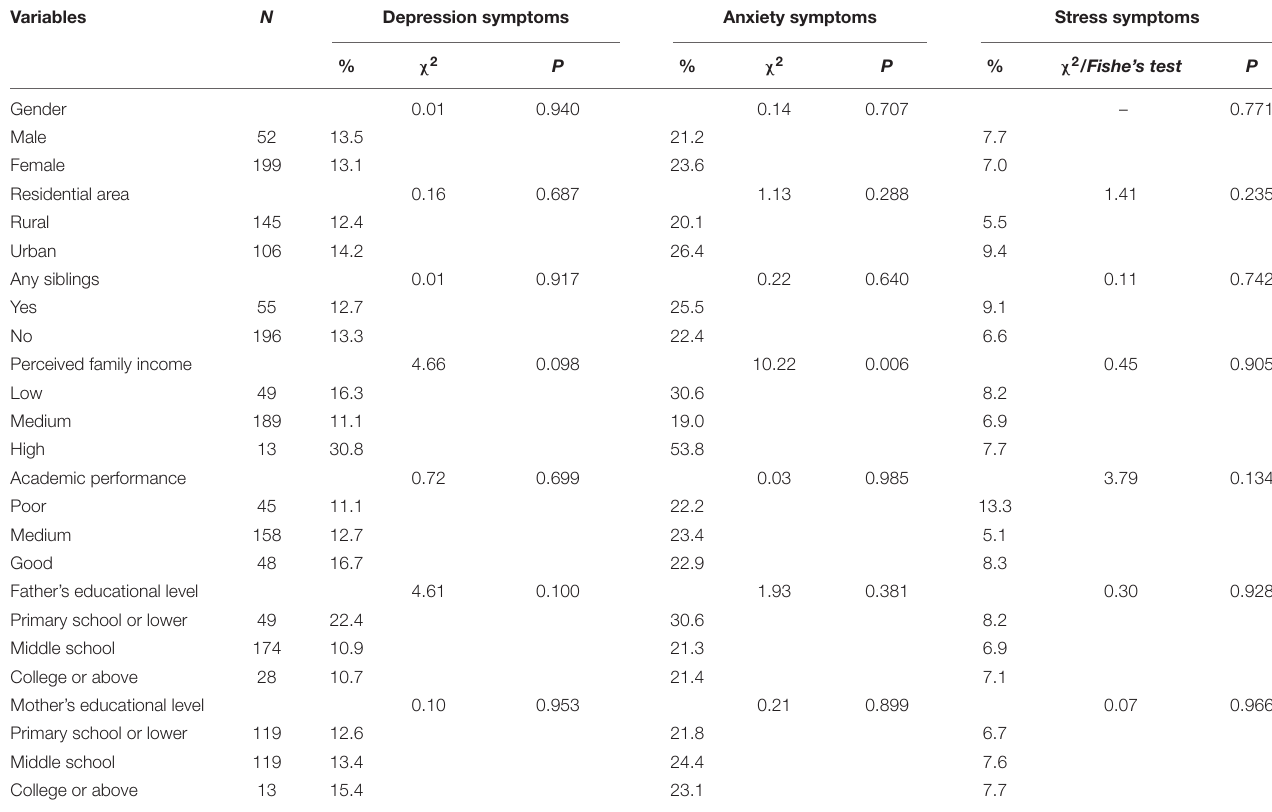
TABLE 1 | Demographic characteristics of the participants.